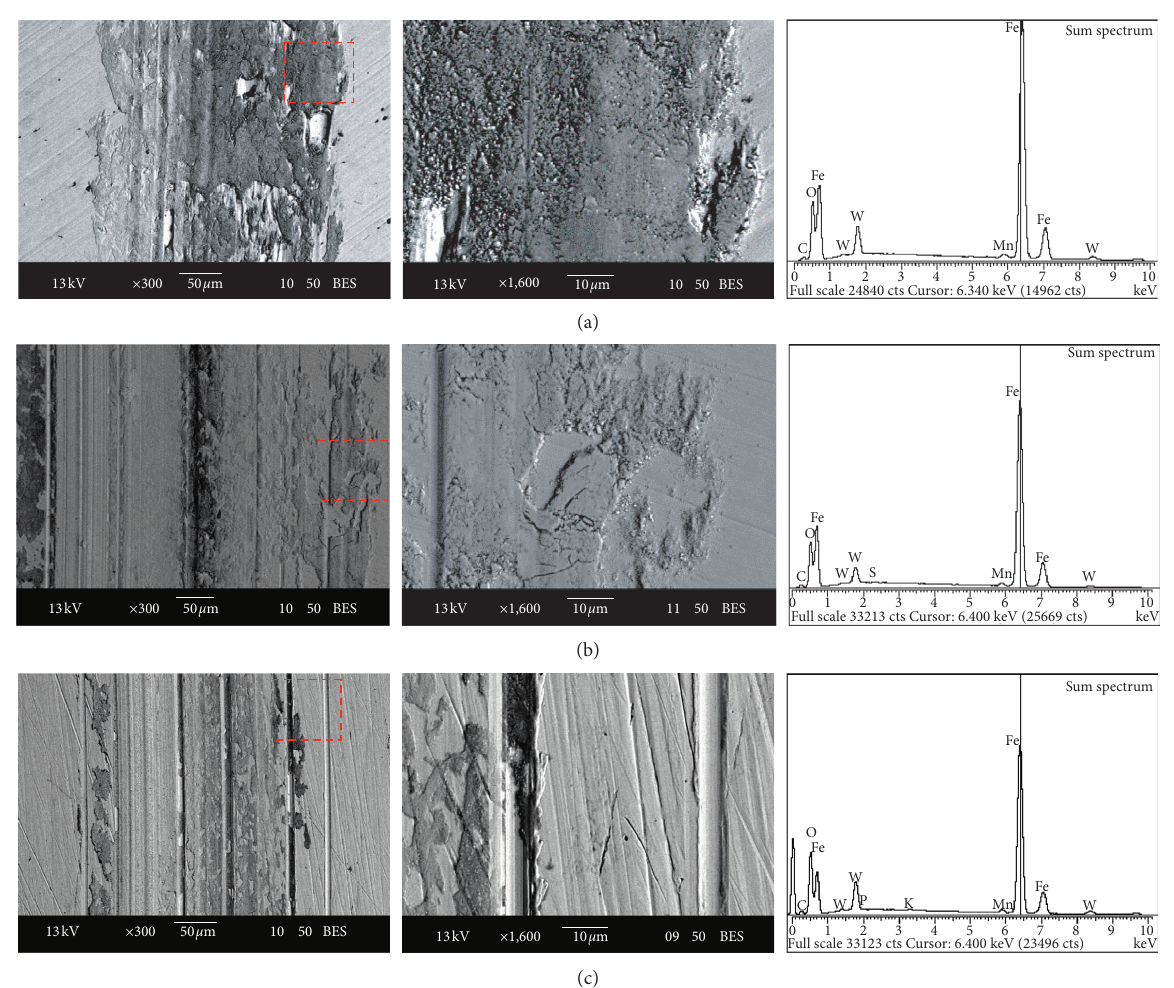
Figure 9: SEM images (first column) of the wear tracks generated on the surface of the steel disk at a distance of 500m enlarged image (second column) of the region enclosed in red square, and the corresponding EDS profiles (third column). First, second, and third rows correspond to (a) RAW, (b) CQT, and (c) LQ